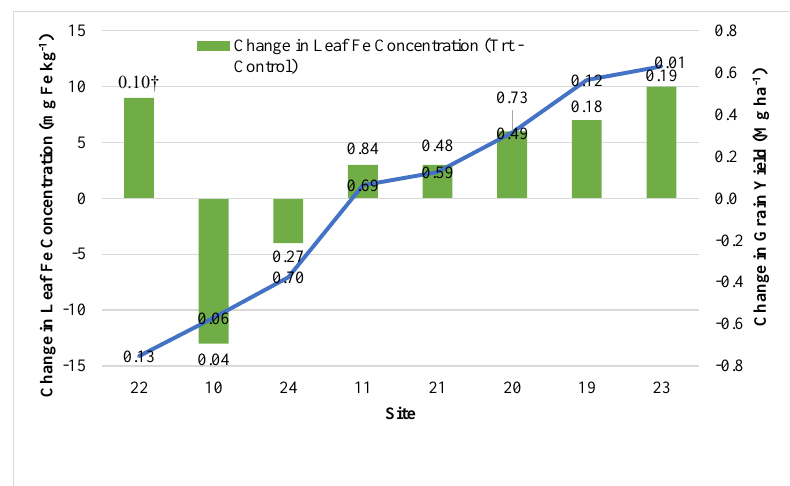
Figure 3. Leaf Fe concentration (bars) and maize grain yield (line) responses to foliar Fe application for eight sites. Data labels on both the line and bar graphs indicate p -values † for mean comparison differences. The correlation coefficient (r) for the relationship of changes in tissue Fe concentration and grain yield due to foliar Fe application is 0.54. These sites were the only sites with visual signs of micronutrient deficiency.